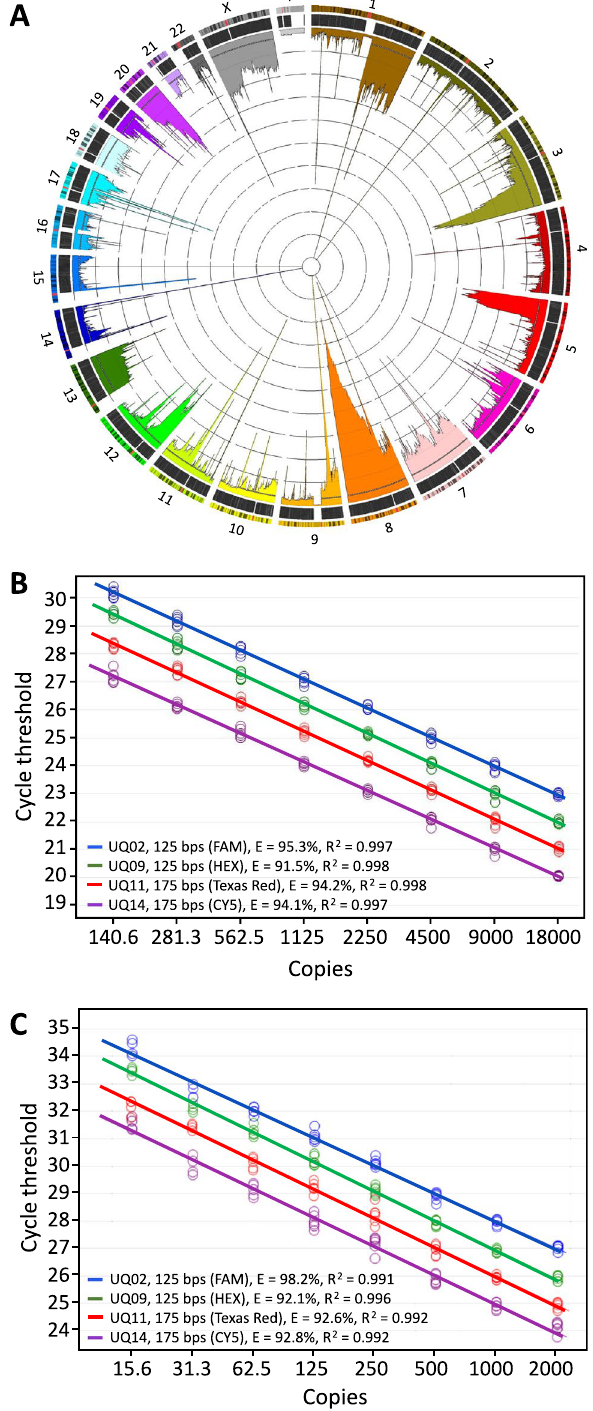
Figure 2. Design and performance of PCR assays against copy-neutral regions in the genome. ( A ) Circos plot depicting the percent of samples that undergo copy number aberration (CNA) in cancer. Chromosomes are shown in the outermost ring and include an overlay of cytogenetic Giemsa banding and centromeres marked with a red band. The second outermost ring shows the 946,615 Affymetrix Genome-Wide Human SNP Array 6.0 copy number probes used for the detection of CNAs by the TCGA. The final layer is a histogram displaying the number of samples that underwent statistically significant CNA (either loss or gain) within each region. Each grid line represents 1% of the 10,610 total samples. Universal assays were designed to target regions in the bottom 10th percentile of CNAs, excluding regions that are not covered by the Affymetrix CNV probes (e.g., centromeres). Less than 35 of the 10,610 samples (< 0.33%) have CNAs in these regions, represented on the histogram as a dotted white line (above which regions were excluded). ( B , C ) Standard curves estimating amplification efficiencies of universal quantitation assays in 4-plex qPCR on gDNA ( B ) and bisulfite-converted DNA ( C ). Curves are artificially offset for better visualisation. E =